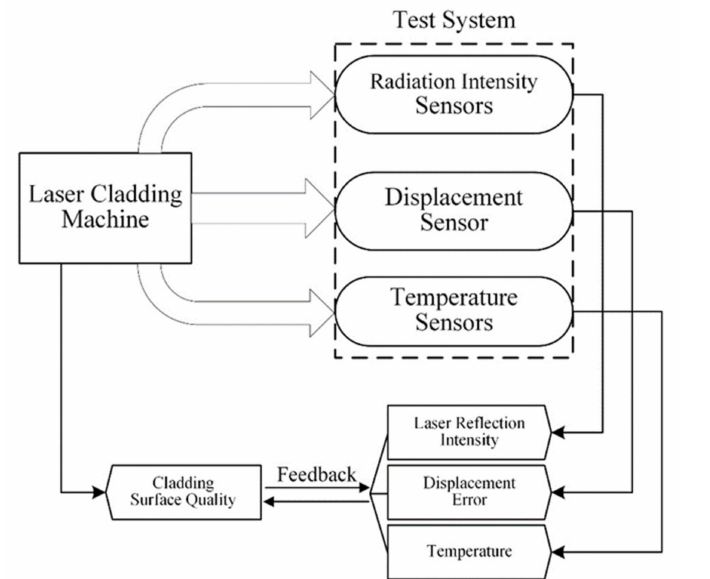
Figure 1. Laser cladding test system.